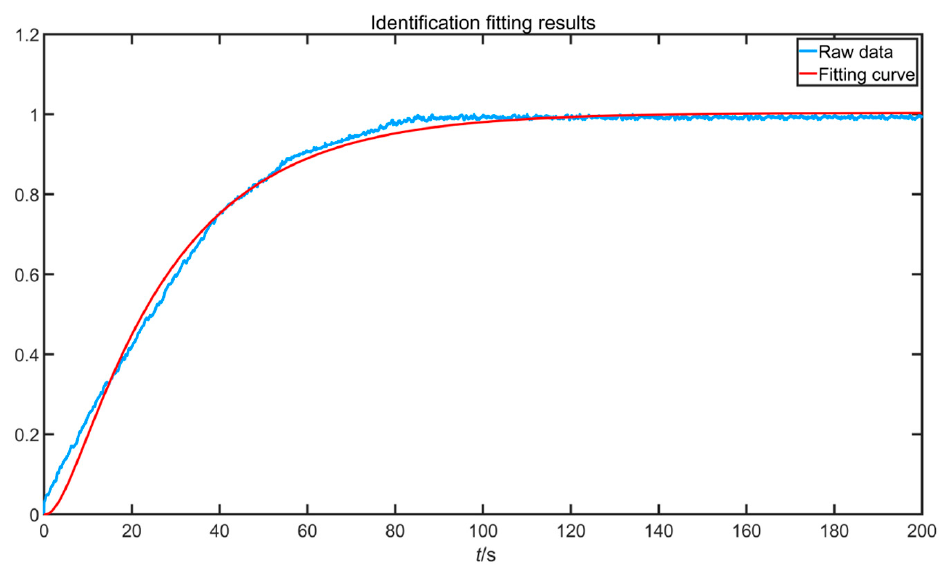
Figure 9. Improved biogeography-based optimization algorithm identification model flow chart.